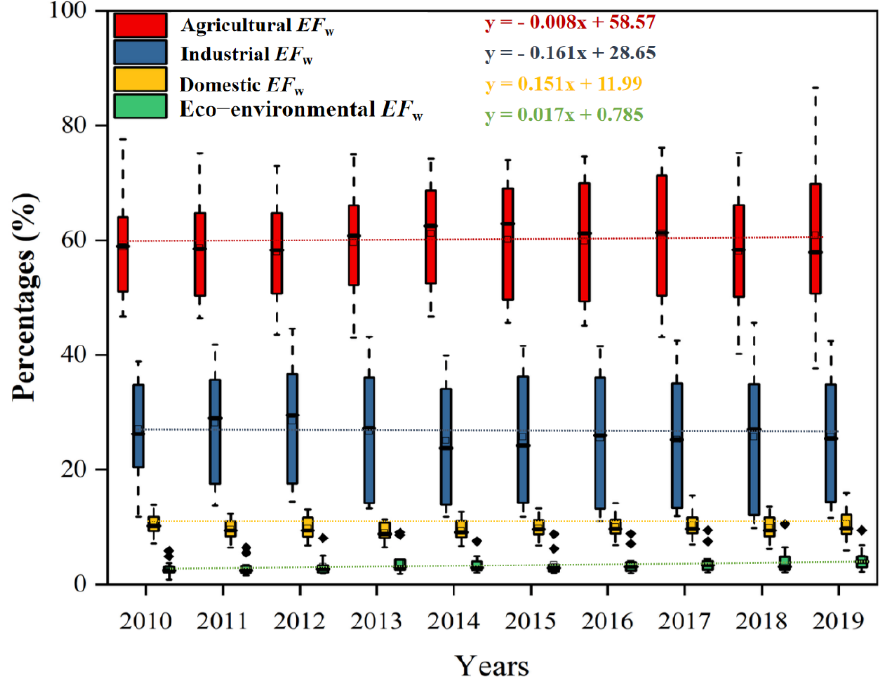
Figure 6. Change in the percentage of EF w components from 2010 to 2019 of the 14 prefecture-level cities. Dotted lines in red, blue, yellow, and green are the trend lines of mean values of agricultural, industrial, domestic, and eco-environmental EF w , respectively.